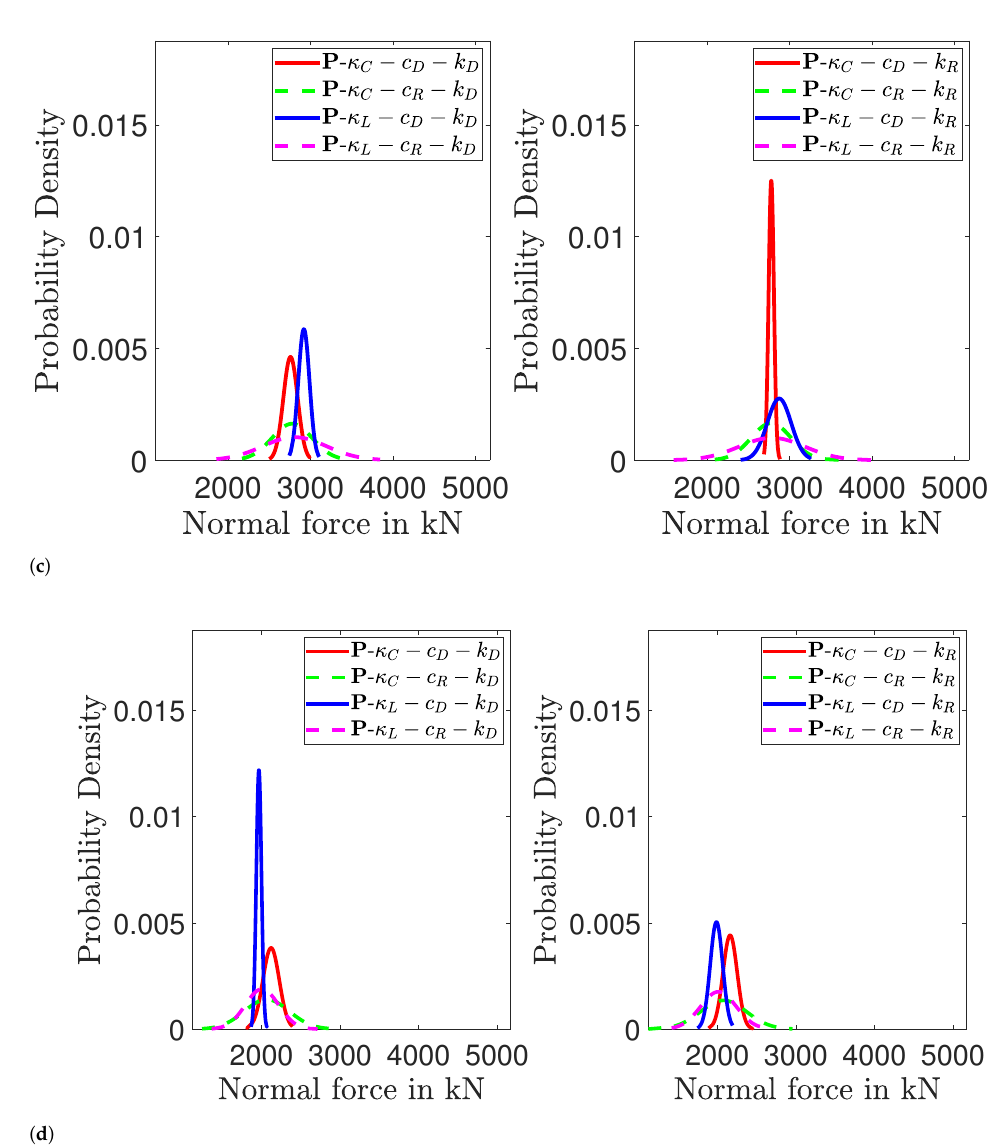
Figure A3. PDFs of the Normal force of the settlement in kN for porous analyses with deterministic shape functions for the stochastic material variables. κ L , κ C stands for the linear and constant distribution for κ respectively while c D , c R stands for the deterministic and random distribution for c respectively and k R , k D stands for the random and deterministic distribution for k. Subplot ( a – d ) stand for eccentricity 0, h , h , h , 6 3 12